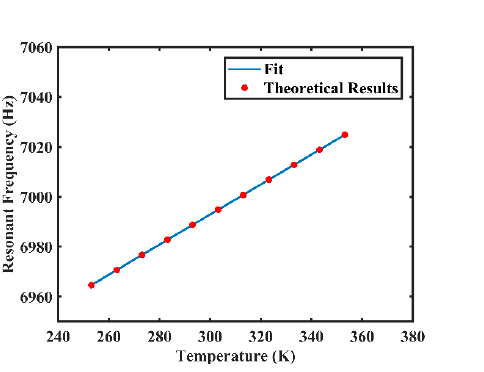
Figure 4. The fitted value of resonant frequency varying with temperature.